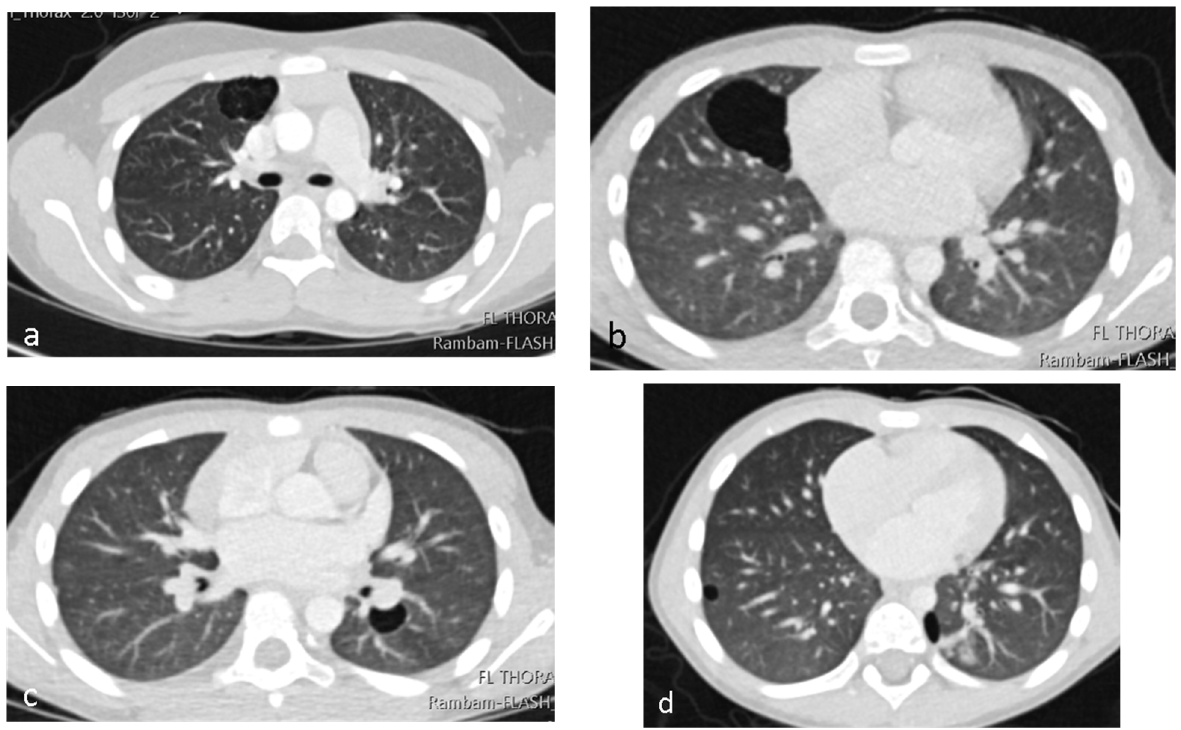
Figure 6. Asymptomatic DICER1 -germline-positive siblings of index patient number 3. Axial images of Chest CTA: ( a ) Nine-year-old girl with RUL anterior multiseptated cystic lesion. ( b , c ) Six-year-old boy with right and left cystic lesion. ( d ) Fifteen-month-old boy with bilateral, small cystic